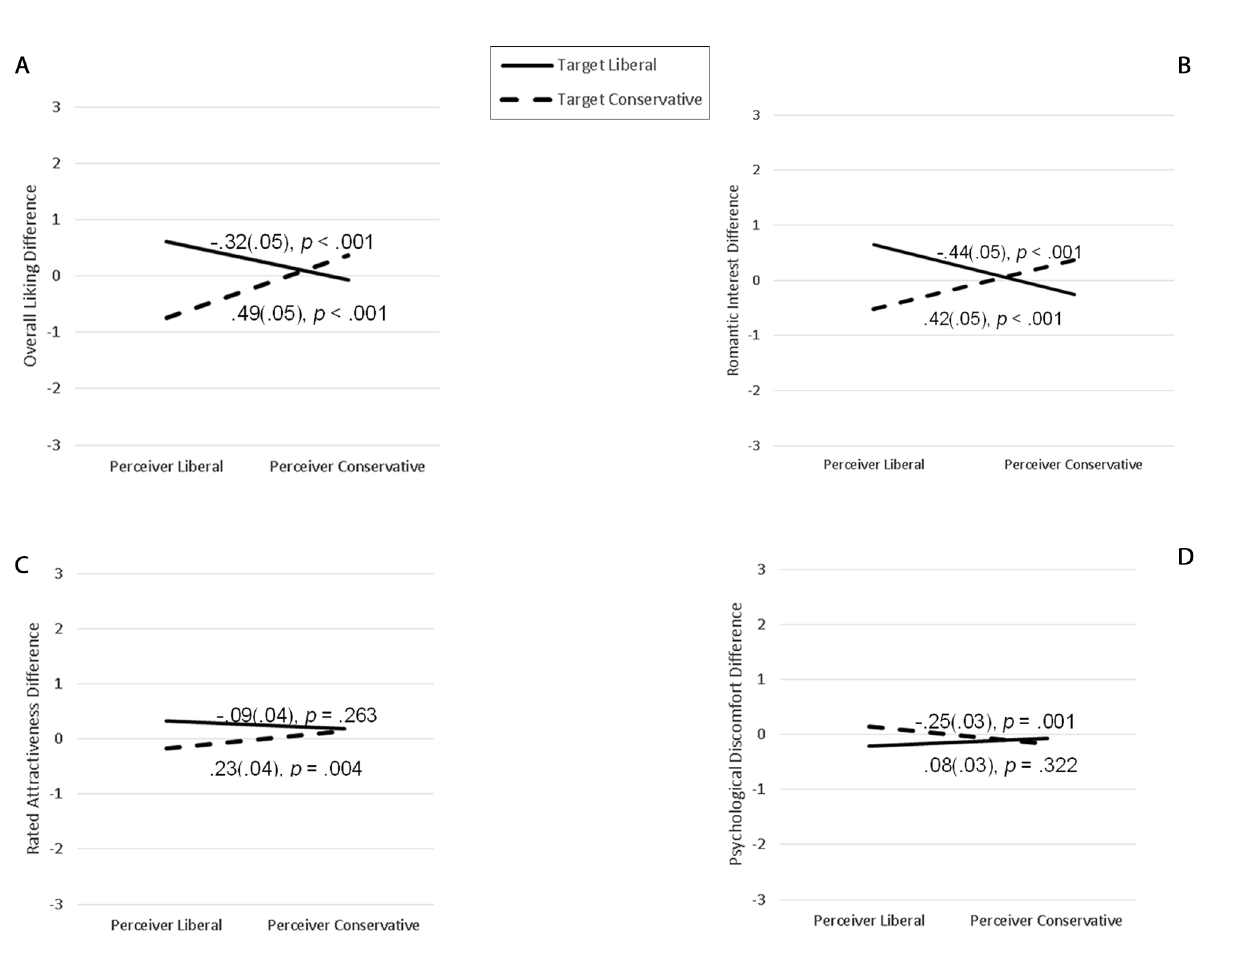
Figure 2. Target Ideology × Perceiver Ideology interactions on dependent variables for Study 2. Standardized regression coefficients are reported for simple slopes and numbers in parentheses represent standard